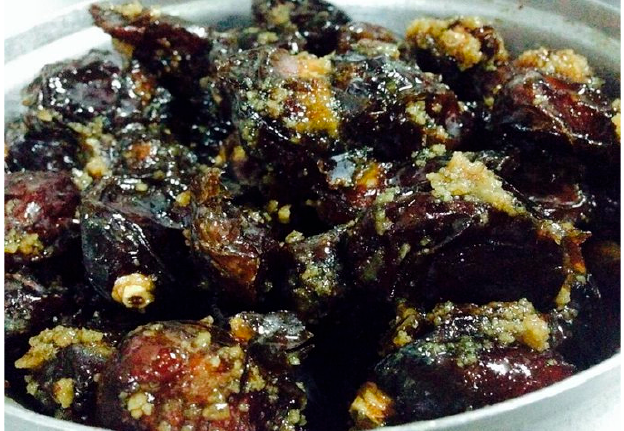
Figure 5. Sample of Al-helwa Macnooz dates.